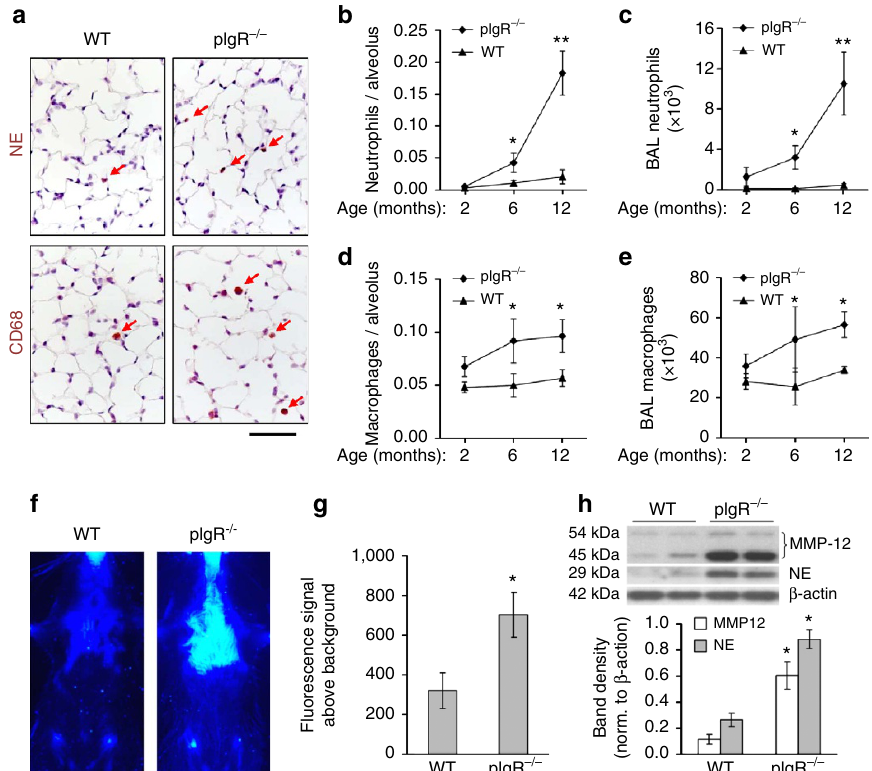
Figure 2 | Lung inflammation progresses with age in pIgR (cid:2) / (cid:2) mice. ( a ) Representative immunostains for neutrophils using antibodies to neutrophil elastase (NE) or macrophages using antibodies to CD68 in 12-month-old WTand pIgR (cid:2) / (cid:2) mice. Positive cells are stained brown (indicated by red arrows) (original magnification, (cid:3) 200). Scale bar, 50 m m. ( b – e ) Neutrophil (NE þ ) and macrophage (CD68 þ ) counts in lungs of pIgR (cid:2) / (cid:2) and age-matched WT littermate controls at the indicated ages, and neutrophil and macrophage counts in BAL fluid. Five to seven mice per group; * P o 0.05 compared with 2-month-old pIgR (cid:2) / (cid:2) mice and age-matched WT mice; ** P o 0.01 compared with all other groups (two-way analysis of variance (ANOVA)). ( f ) Representative image of folate-PEG-Cy5-derived chest fluorescence 4h after intravenous probe injection in 12-month-old WT and pIgR (cid:2) / (cid:2) mice. ( g ) Photon emission from the chest normalized to background before injection of probe. Three to four mice per group; * P o 0.05 (Student’s t -test). ( h ) Western blotting and densitometry for MMP-12 (two bands at 45 and 54kDa) and NE (29kDa) in lung tissue from 12-month-old WTand pIgR (cid:2) / (cid:2) mice. Band densities of MMP-12 and NE were normalized to b -actin. Six mice per group; * P o 0.01 compared with WT mice (Student’s t patients with COPD 40,41 . Compared with WT mice, pIgR (cid:2) / (cid:2) pIgR (cid:2) / (cid:2) mice. First, we measured total bacterial DNA by mice treated with aerosolized NTHi lysate had increased quantitative PCR targeting the V1/V2 portion of bacterial 16S rRNA in 9-month-old mice and found no difference in total bacterial burden in the lungs of WT and pIgR (cid:2) / (cid:2) mice (Fig. 3e). Subsequently, we used high-throughput amplicon sequencing to evaluate microbial communities in whole lung tissue from 6-month-old WT and pIgR (cid:2) / (cid:2) mice. As has been reported previously 38 , Proteobacteria and Firmicutes were the most common bacterial phyla present in the lungs of both groups of mice (Fig. 3f). Compared with WT mice, pIgR (cid:2) / (cid:2) mice had a twofold increase (400 versus 194) in the number of detected operational taxonomic units (OTUs) (Fig. 3f and Supplementary vehicle (Fig. 4e–g and Fig. 3). Analysis by Random Forests, a supervised machine learning technique, was used to classify microbial taxa that discriminate the mouse genotypes 39 . Ten OTUs that best discriminate the genotypes are shown in Supplementary Fig. 4.